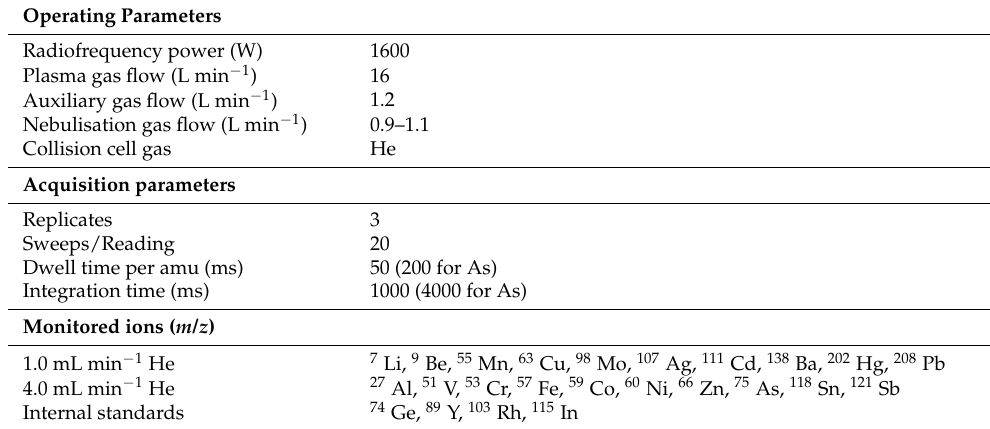
Table 2. ICP-MS parameters for metal determination in